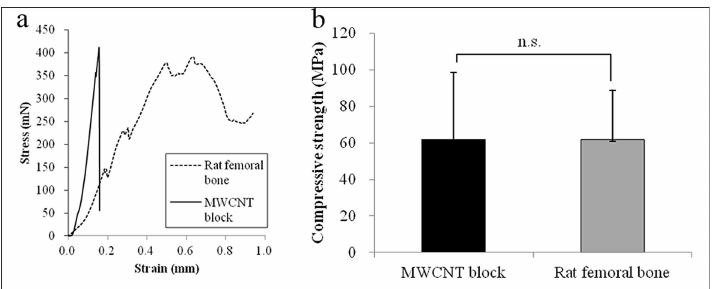
Fig 2. Compression test. (a) Compressive strength of both samples.(b) Representative load-displacement curves of MWCNT blocks and rat femoral bone specimens. Valuesare mean ± S.D.; n = 5.